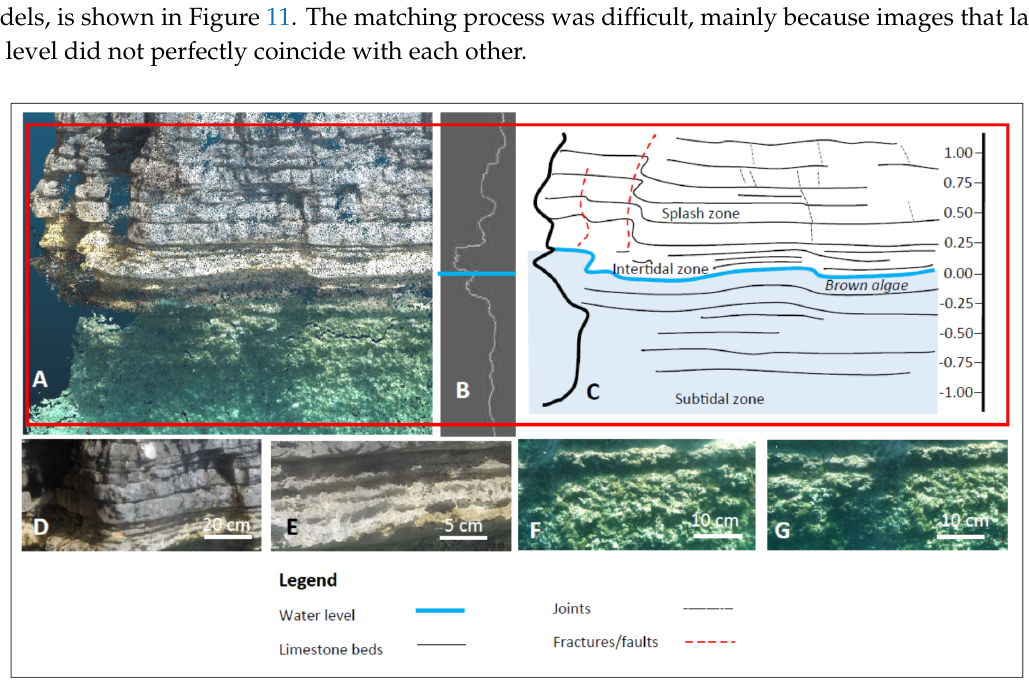
Figure 11. Example of dense cloud of a sector of plunging cli ff s at site 2. The dense cloud shows that there are some gaps in the model, but the morphology of the cli ff is recognizable. ( A ) The dense cloud; ( B ) the profile of the cli ff obtained from the dense cloud; ( C ) geological / geomorphological interpretation of the intertidal and nearshore zone reproduced in ( A ). The legend is in the bottom center of the figure; ( D , E ) enlargements of the textured model of the cli ff awl; ( F , G ) enlargement of the textured model of the cli ff